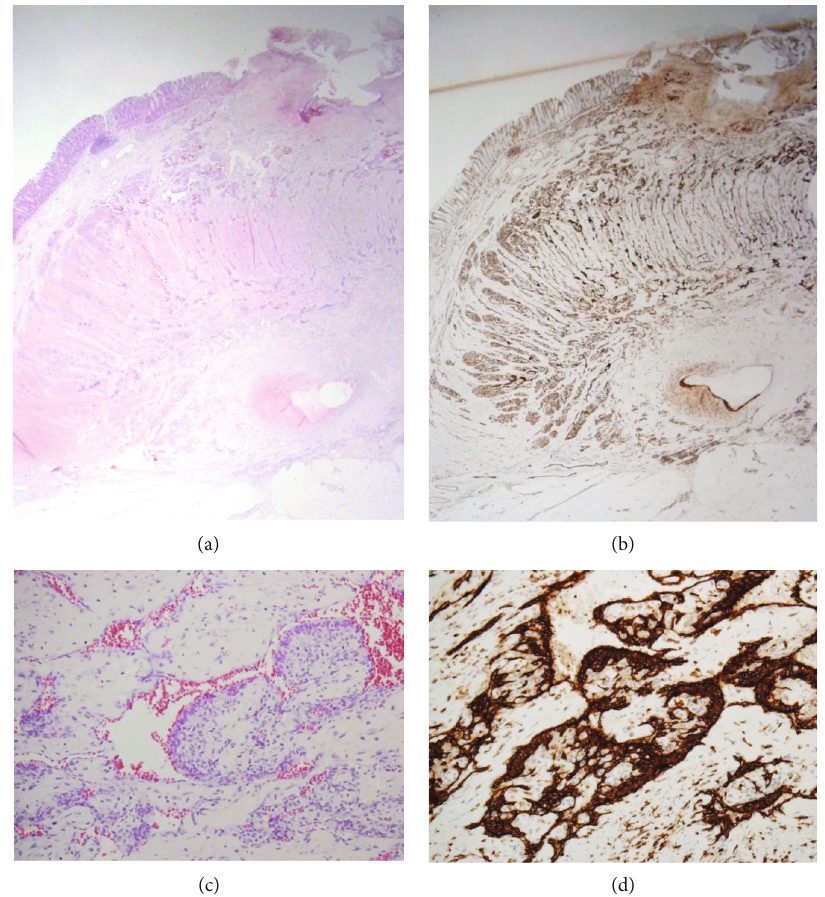
Figure 3: Pathologic fi ndings. (a) Vascular proliferation is observed throughout the entire wall, centered on the muscularis propria (H&E staining, × 40). (b) In addition to the typical lobular arrangement, the feeding vessels exhibit vertical alignment (CD31 IHC, × 40). (c) Although most vascular endothelial cells are fl at, the focal intraluminal protrusions are lined by cuboidal to columnar cells reminiscent of epithelial cells (H&E staining, × 100). (d) Immunostaining for CD31 con fi rms that the plump cells are endothelial cells (CD31 IHC, ×